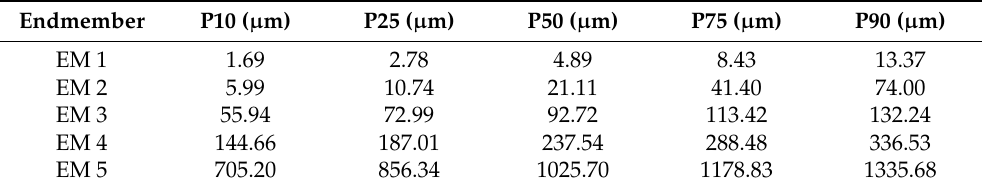
Table 3. The five endmember components of 24 sediment samples in the Lu’erhuan River Sea area of Qinzhou Bay, Guangxi Province.